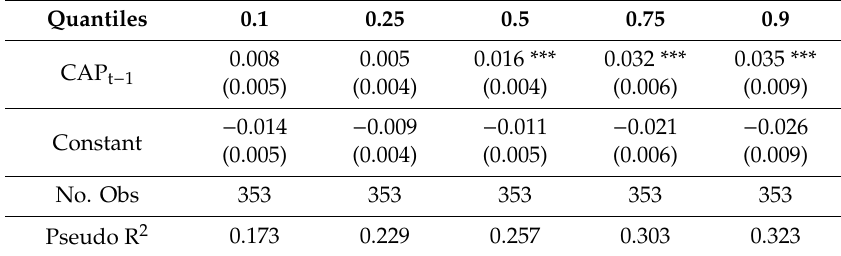
Table 8. Baseline results for ROA: quantile regressions.